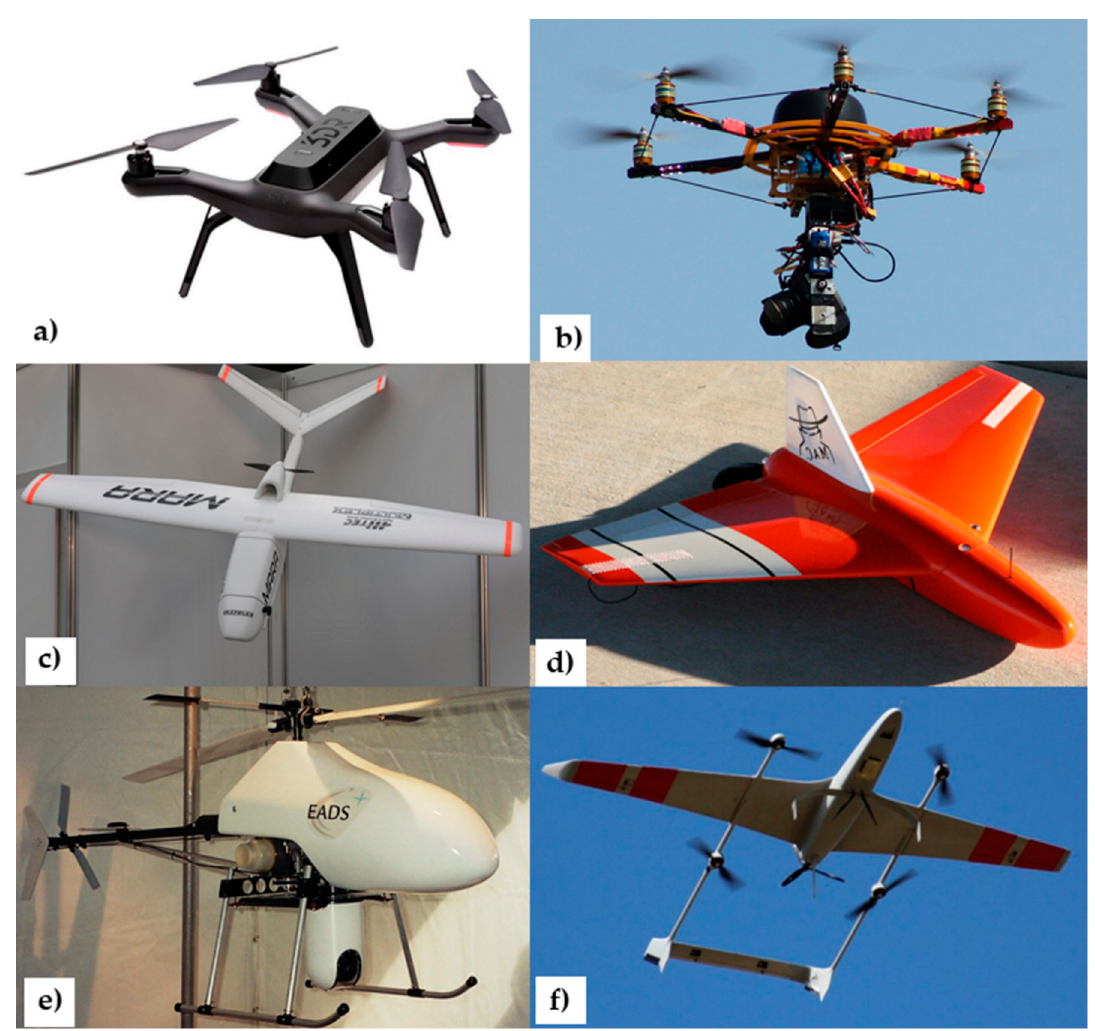
Figure 1. Unmanned aerial vehicle (UAV) types for remote sensing civilian usage: rotary-wing ( a , b ), fixed-wing ( c , d ), unmanned helicopter ( e ), and hybrid solution ( f ).